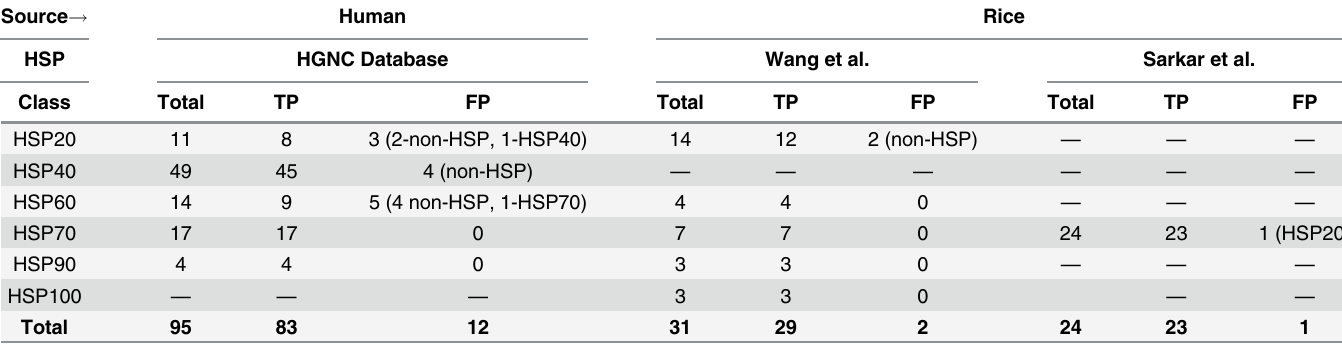
Table 6. Performance of PredHSP on human HSPs obtained from HGNC [14] and rice HSPs obtained from Wang et al. [15] and Sarkar et al. [16]. TP represents true prediction and FP represents false prediction. Source ! Human Rice HSP HGNC Database Wang et al. Sarkar et